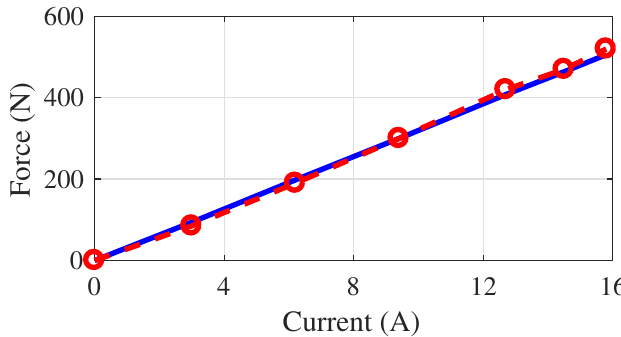
Figure 5. Relationship between input current and thrust.